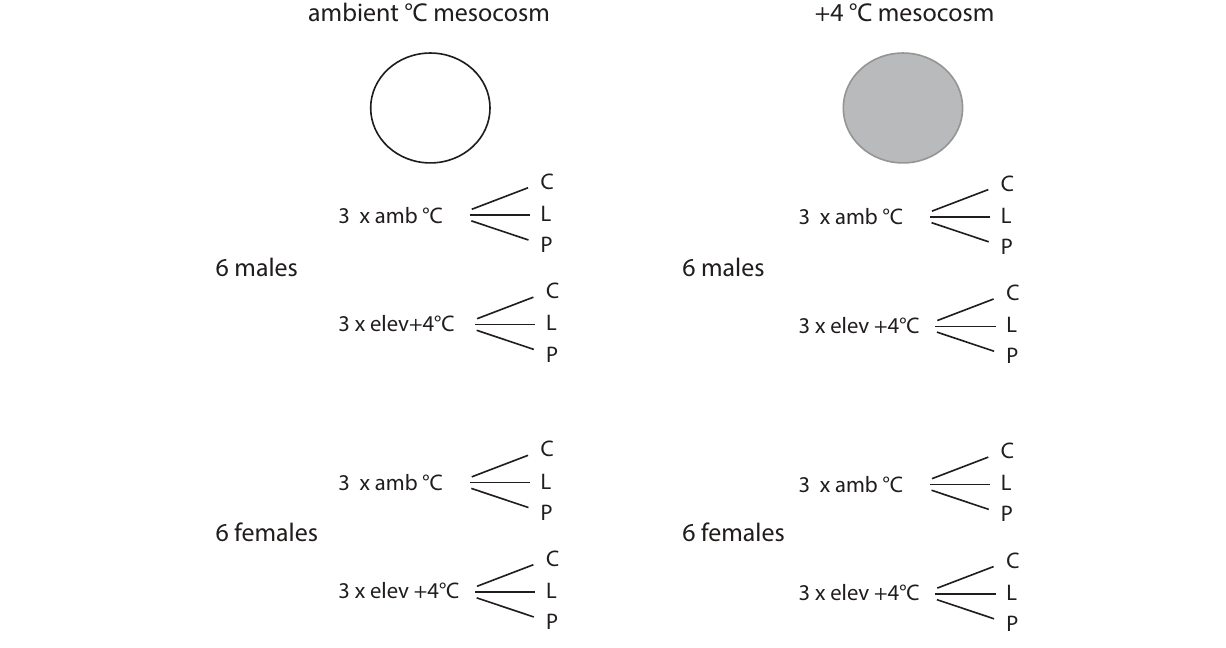
Messtechnik GmbH, Kempten, Germany). A nest report